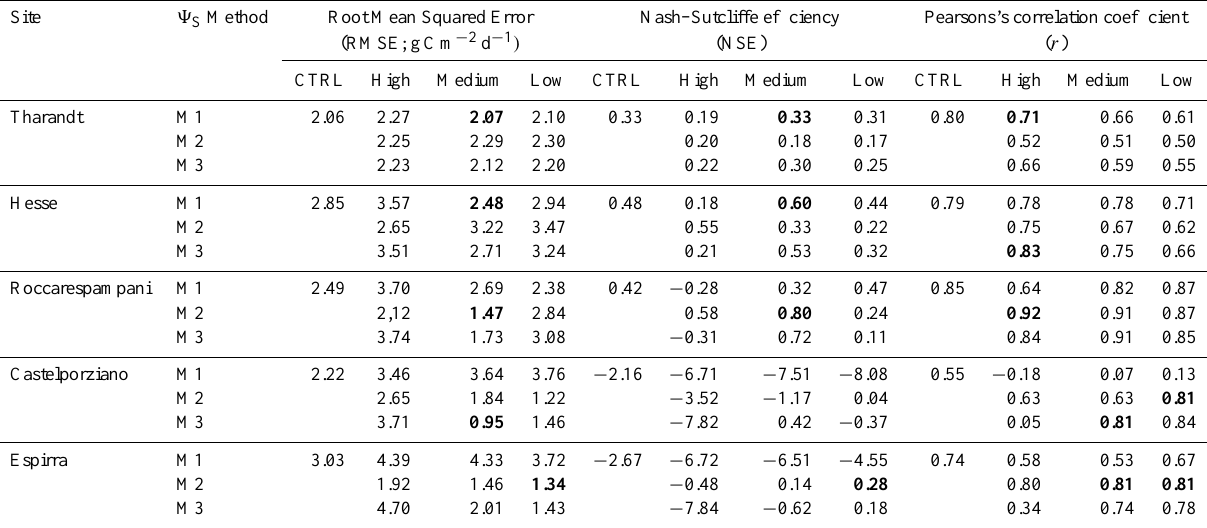
Table 5. Summary statistics of modelled and flux-derived gross primary productivity (GPP) at the five FLUXNET sites during the main drought period (1 June to 31 August 2003). The results of the three parameterisations, which represent a spectrum of behaviour, ranging from high to low drought sensitivity, are shown for the three tested approaches (M1–M3) to obtain a weighted estimate of soil water potential ( (cid:57) S ) across CABLE’s soil layers. M1 uses a root-biomass weighted soil water content converted to (cid:57) S , M2 calculates (cid:57) S by integrated soil water content over the top 1.7m of the soil, and M3 is calculated using a dynamic weighting across soil layers. Sites have been ordered to show a mesic-xeric transition between sites (Tharandt to Espirra). For each site the best performing model simulation has been highlighted in